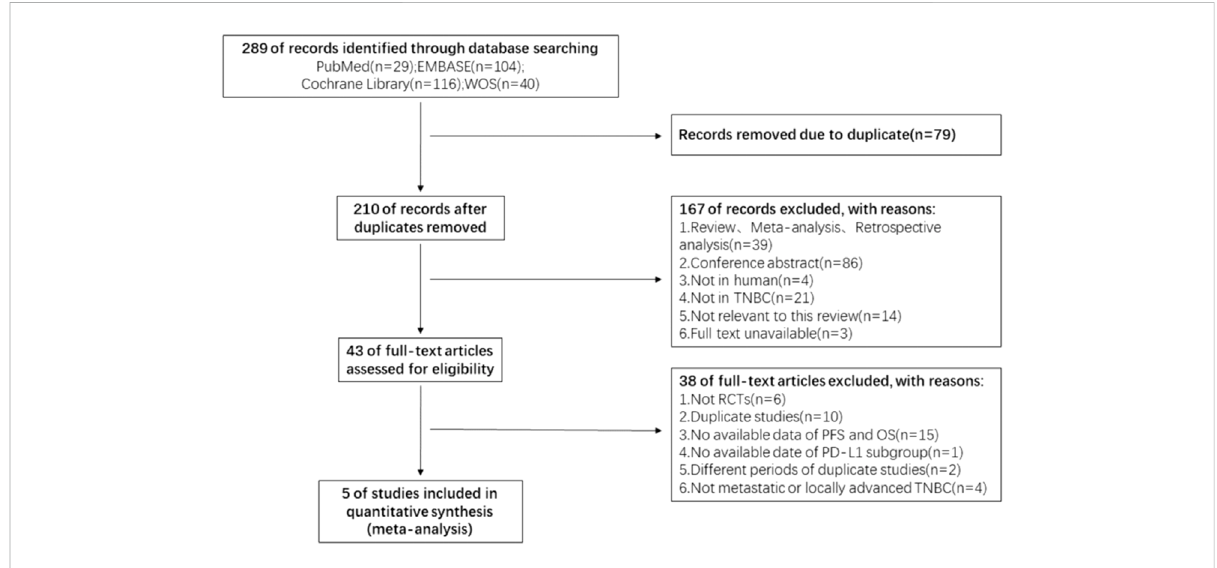
FIGURE 1 Flow chart of the literature search and study selection.